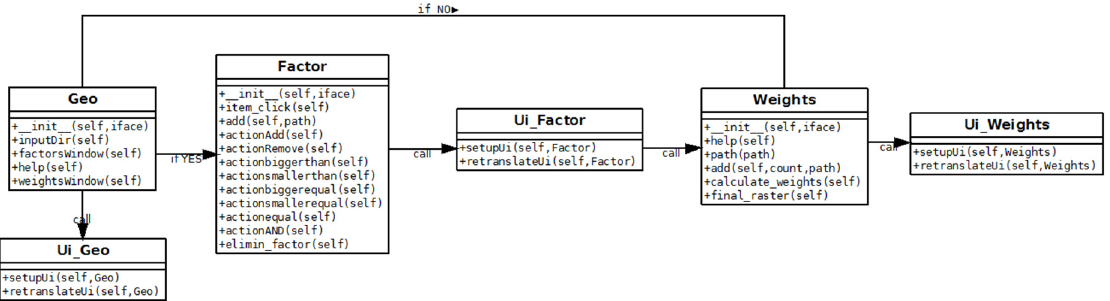
Figure 6. GeoDecision class diagram.